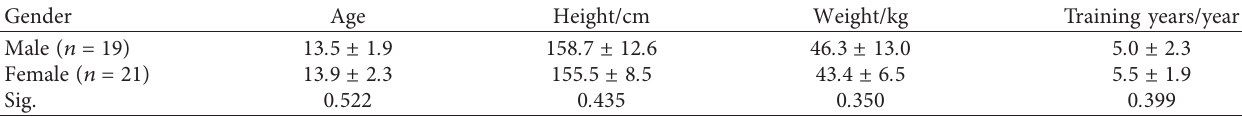
Table 1: Overview of the basic situation of the research object.